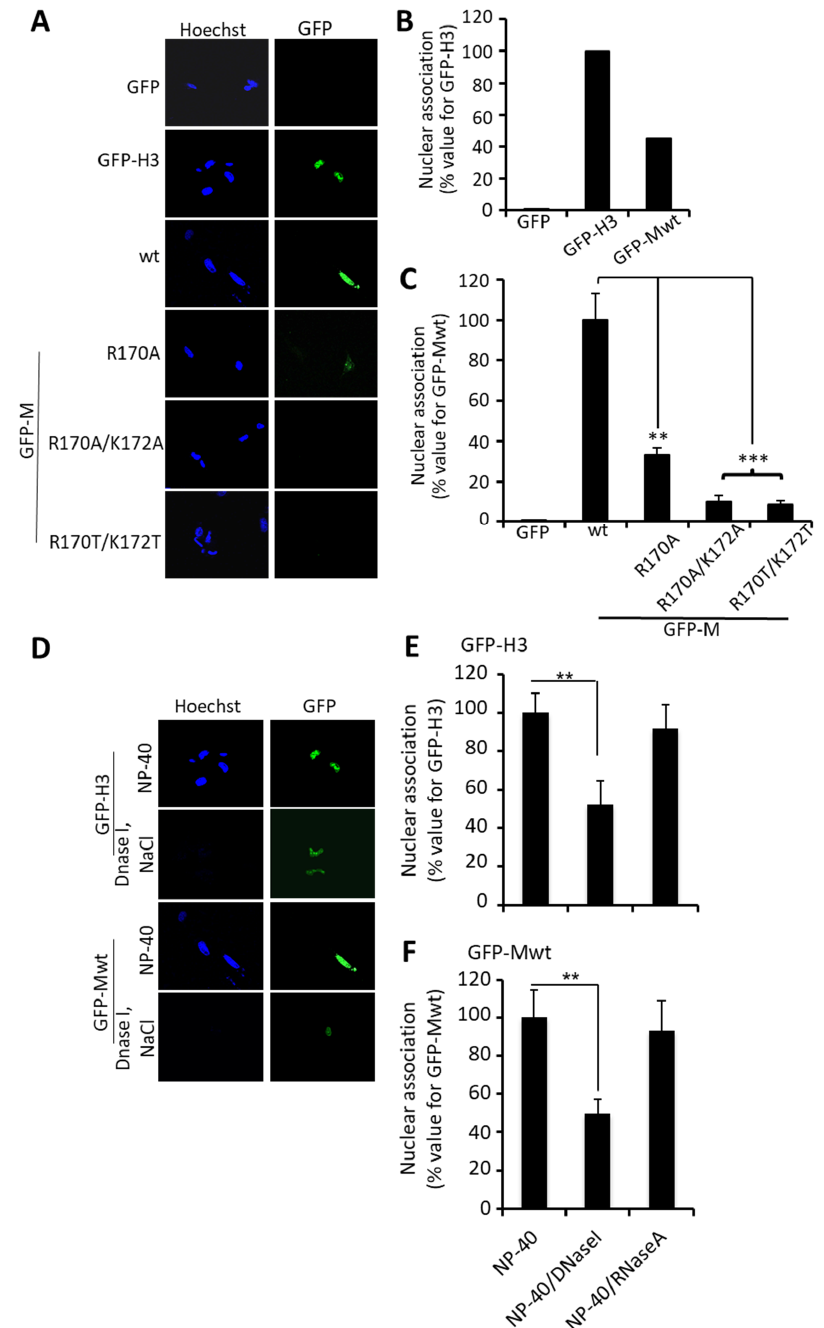
Figure 5. M can associate with chromatin in living cells dependent on residues R170 and K172. ( A – C ) Nuclear association of GFP alone or the indicated GFP fusion proteins (H3 histone, Mwt and mutants M-R170A and R170A/K172A) was assayed 24 h after transfection of HeLa cells by treating with 1% NP-40 for 15 min at room temperature. ( A ) Cells were subjected